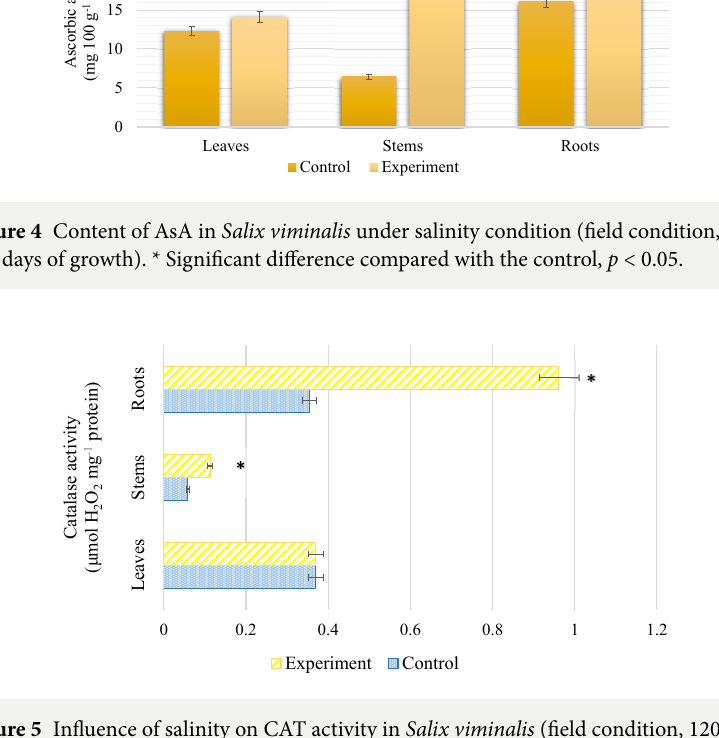
Figure 5 Influence of salinity on CAT activity in Salix viminalis (field condition, 120 days of growth). * Significant difference compared with control, p < 0.05.